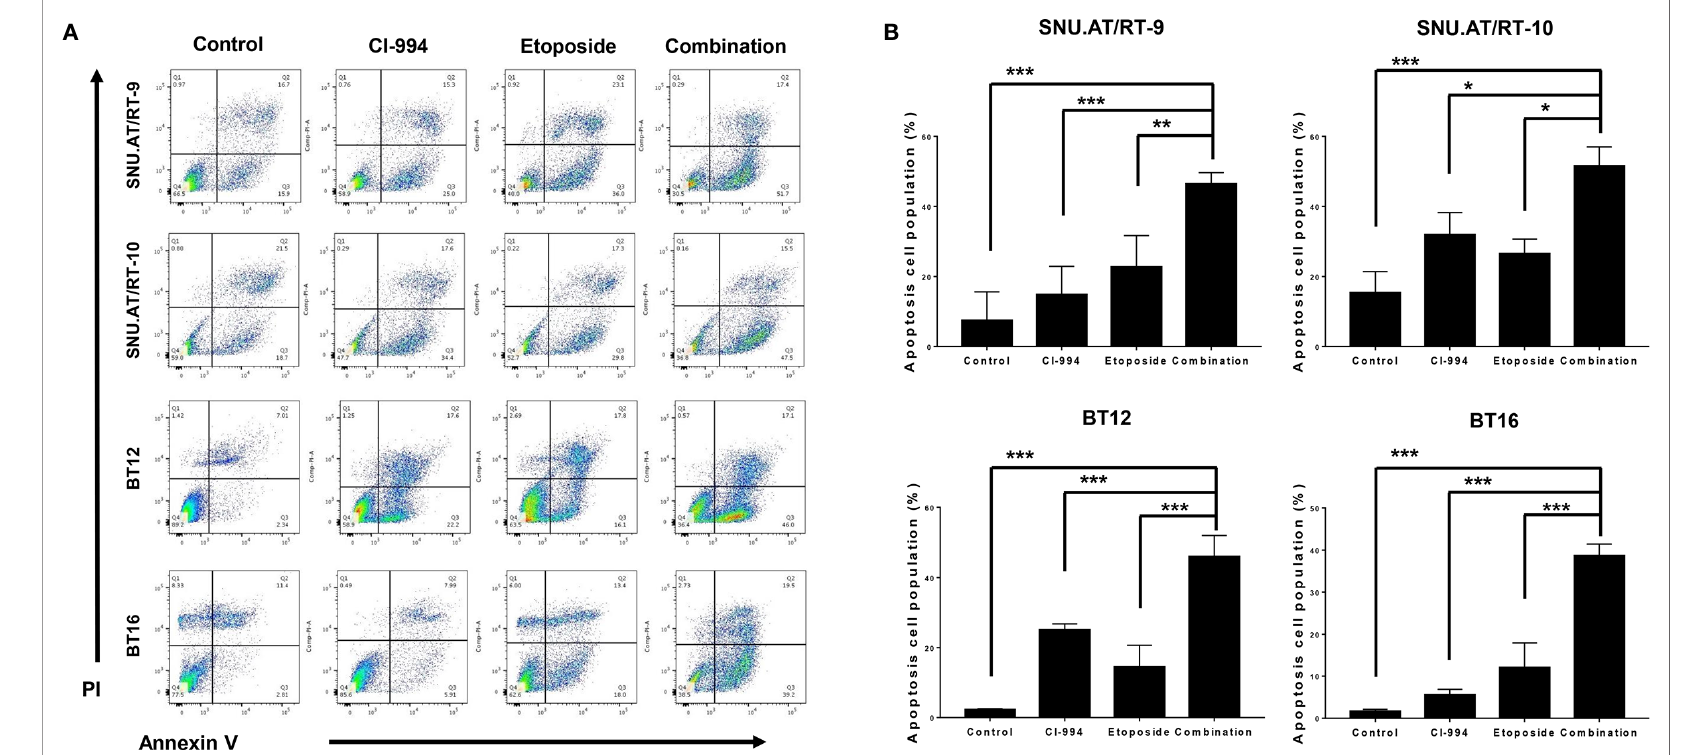
FIGURE 6 | Effect of the combination treatment of CI-994 with etoposide on apoptosis in AT/RT cells. (A) Apoptosis in AT/RT cells was analyzed by Annexin V-FITC/propidium iodide assay and fl ow cytometry. (B) Percentages of apoptotic cells are presented on graphs. Combination of CI-994 with etoposide more considerably induced apoptosis in all AT/RT cells than the single treatment. *p < 0.05, **p < 0.001, ***p <